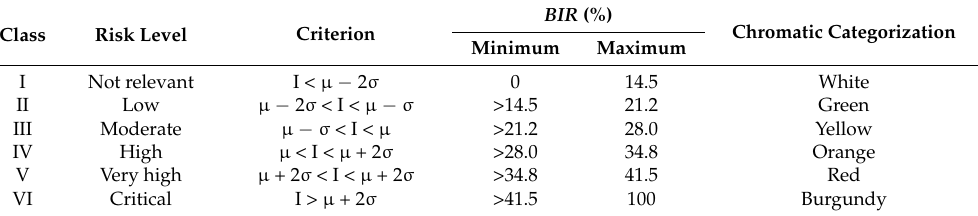
Table 7. Classes of risk.